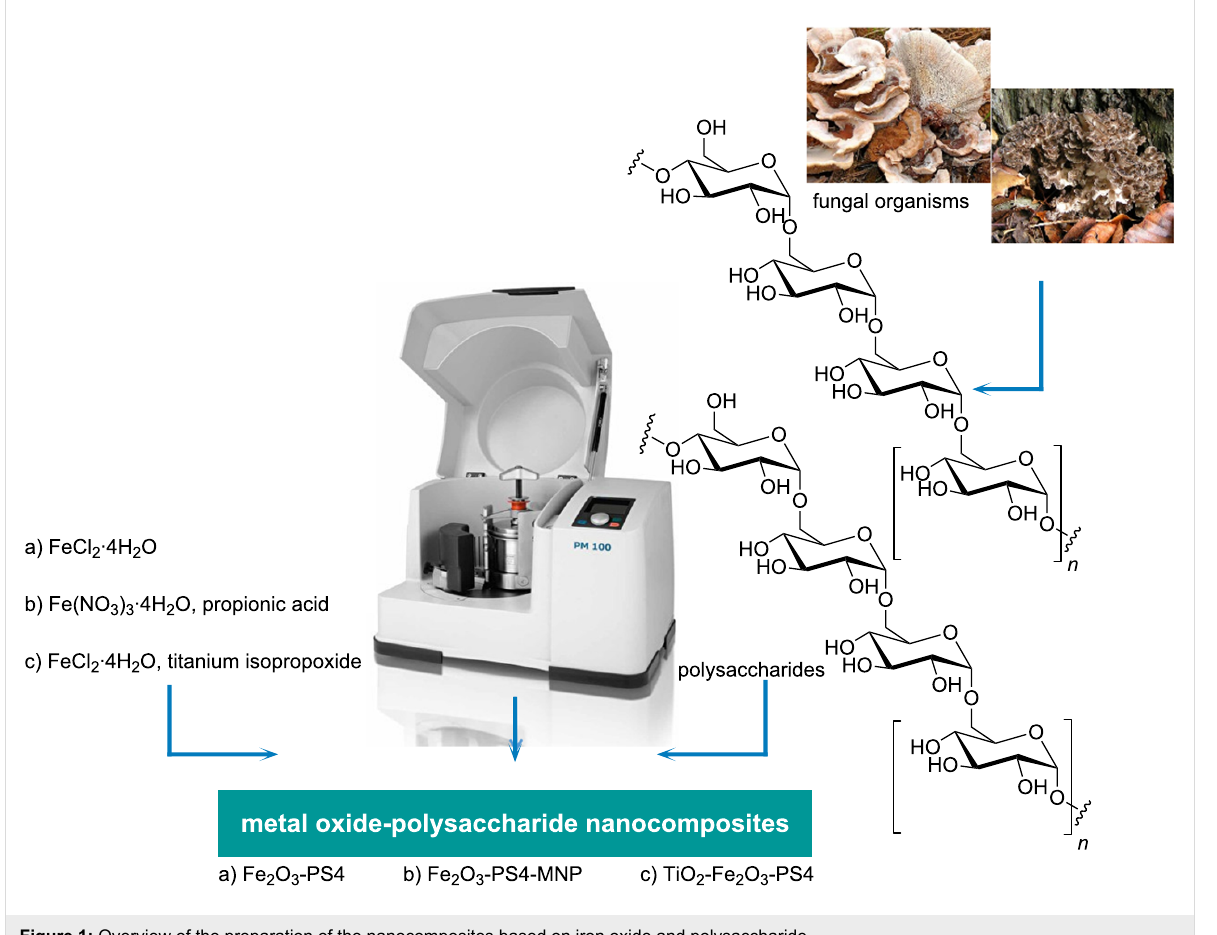
Figure 1: Overview of the preparation of the nanocomposites based on iron oxide and